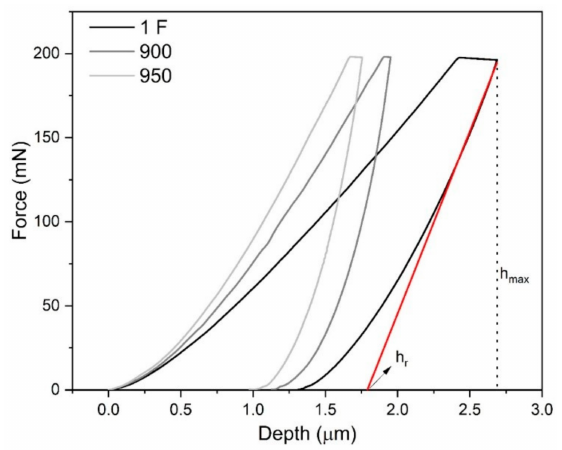
Figure 6. Force vs. depth curves (loading and unloading).